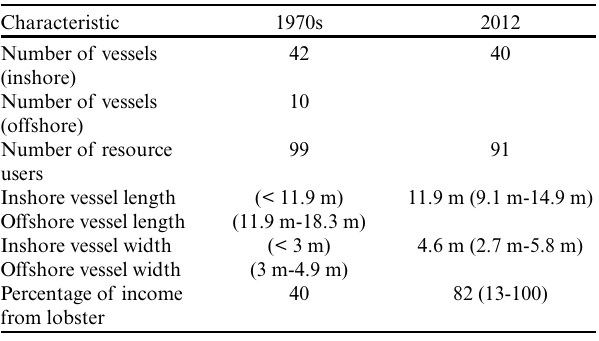
Table 1 . Characteristics of the Port Lameron fishery in the 1970s and today. Values are counts and averages, and ranges are show in